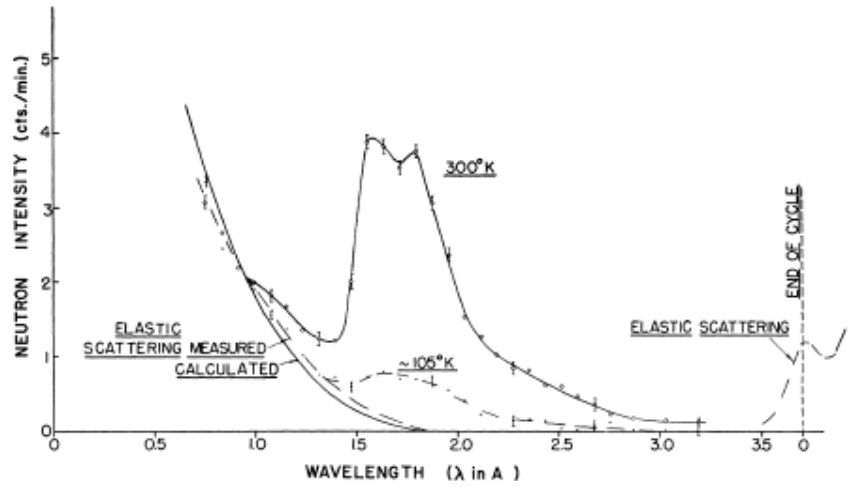
Figure 9. The Be-Pb difference patterns as measured with the filter difference spectrometer for vanadium at 300 °K and at 105 °K. The region of the spectrum around 1.2 Å corresponds to multiphonon scattering. Elastic scattering from the previous frame in time of flight is seen around 3.6 Å. This figure is taken from Figure 3 of ref. [35]. Copyright by the American Physical Society.